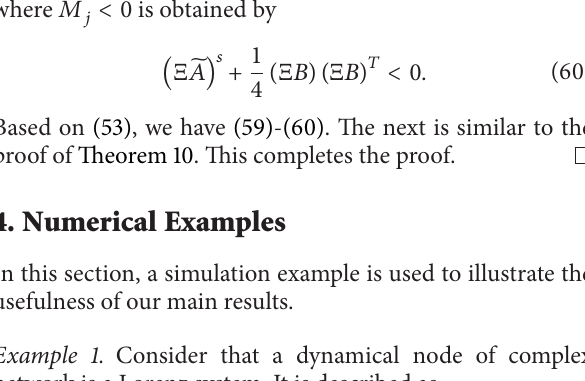
Figure 1: Chaotic orbit of Lorenz’s circuit.